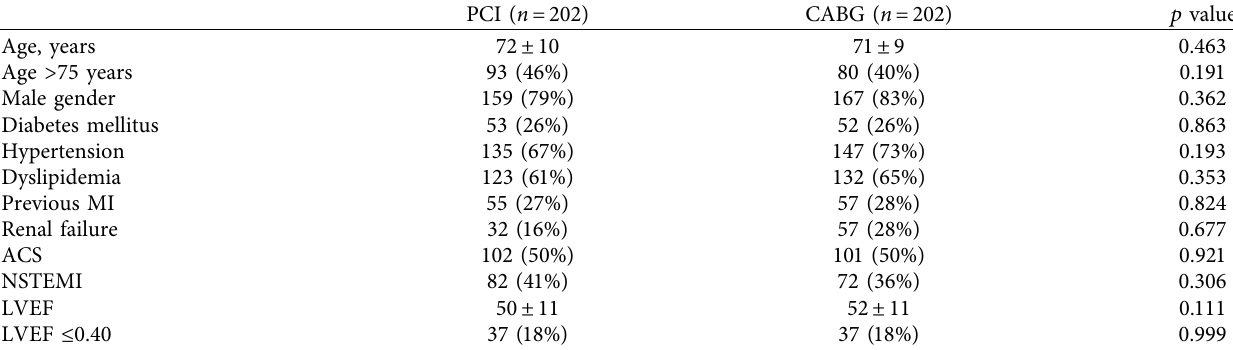
Figure 3: Multivariate analysis for the composite of death, nonfatal myocardial infarction, or stroke. CABG, coronary artery bypass grafting; CR, complete revascularization; PCI, percutaneous coronary intervention. Table 4: Baseline and procedural characteristics of the matched